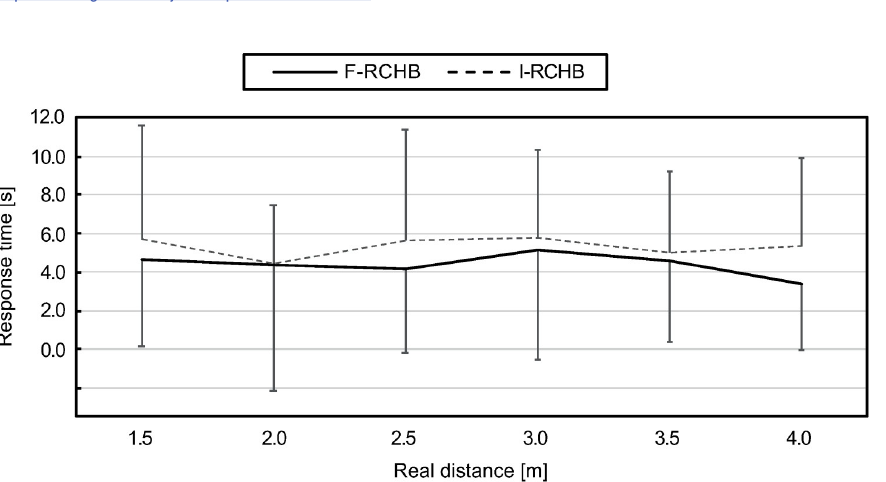
Fig 14. Response time. Mean and standard deviation of the response time depending on the real putting distance under full (F-RCHB) and incomplete (I-RCHB) vision condition.